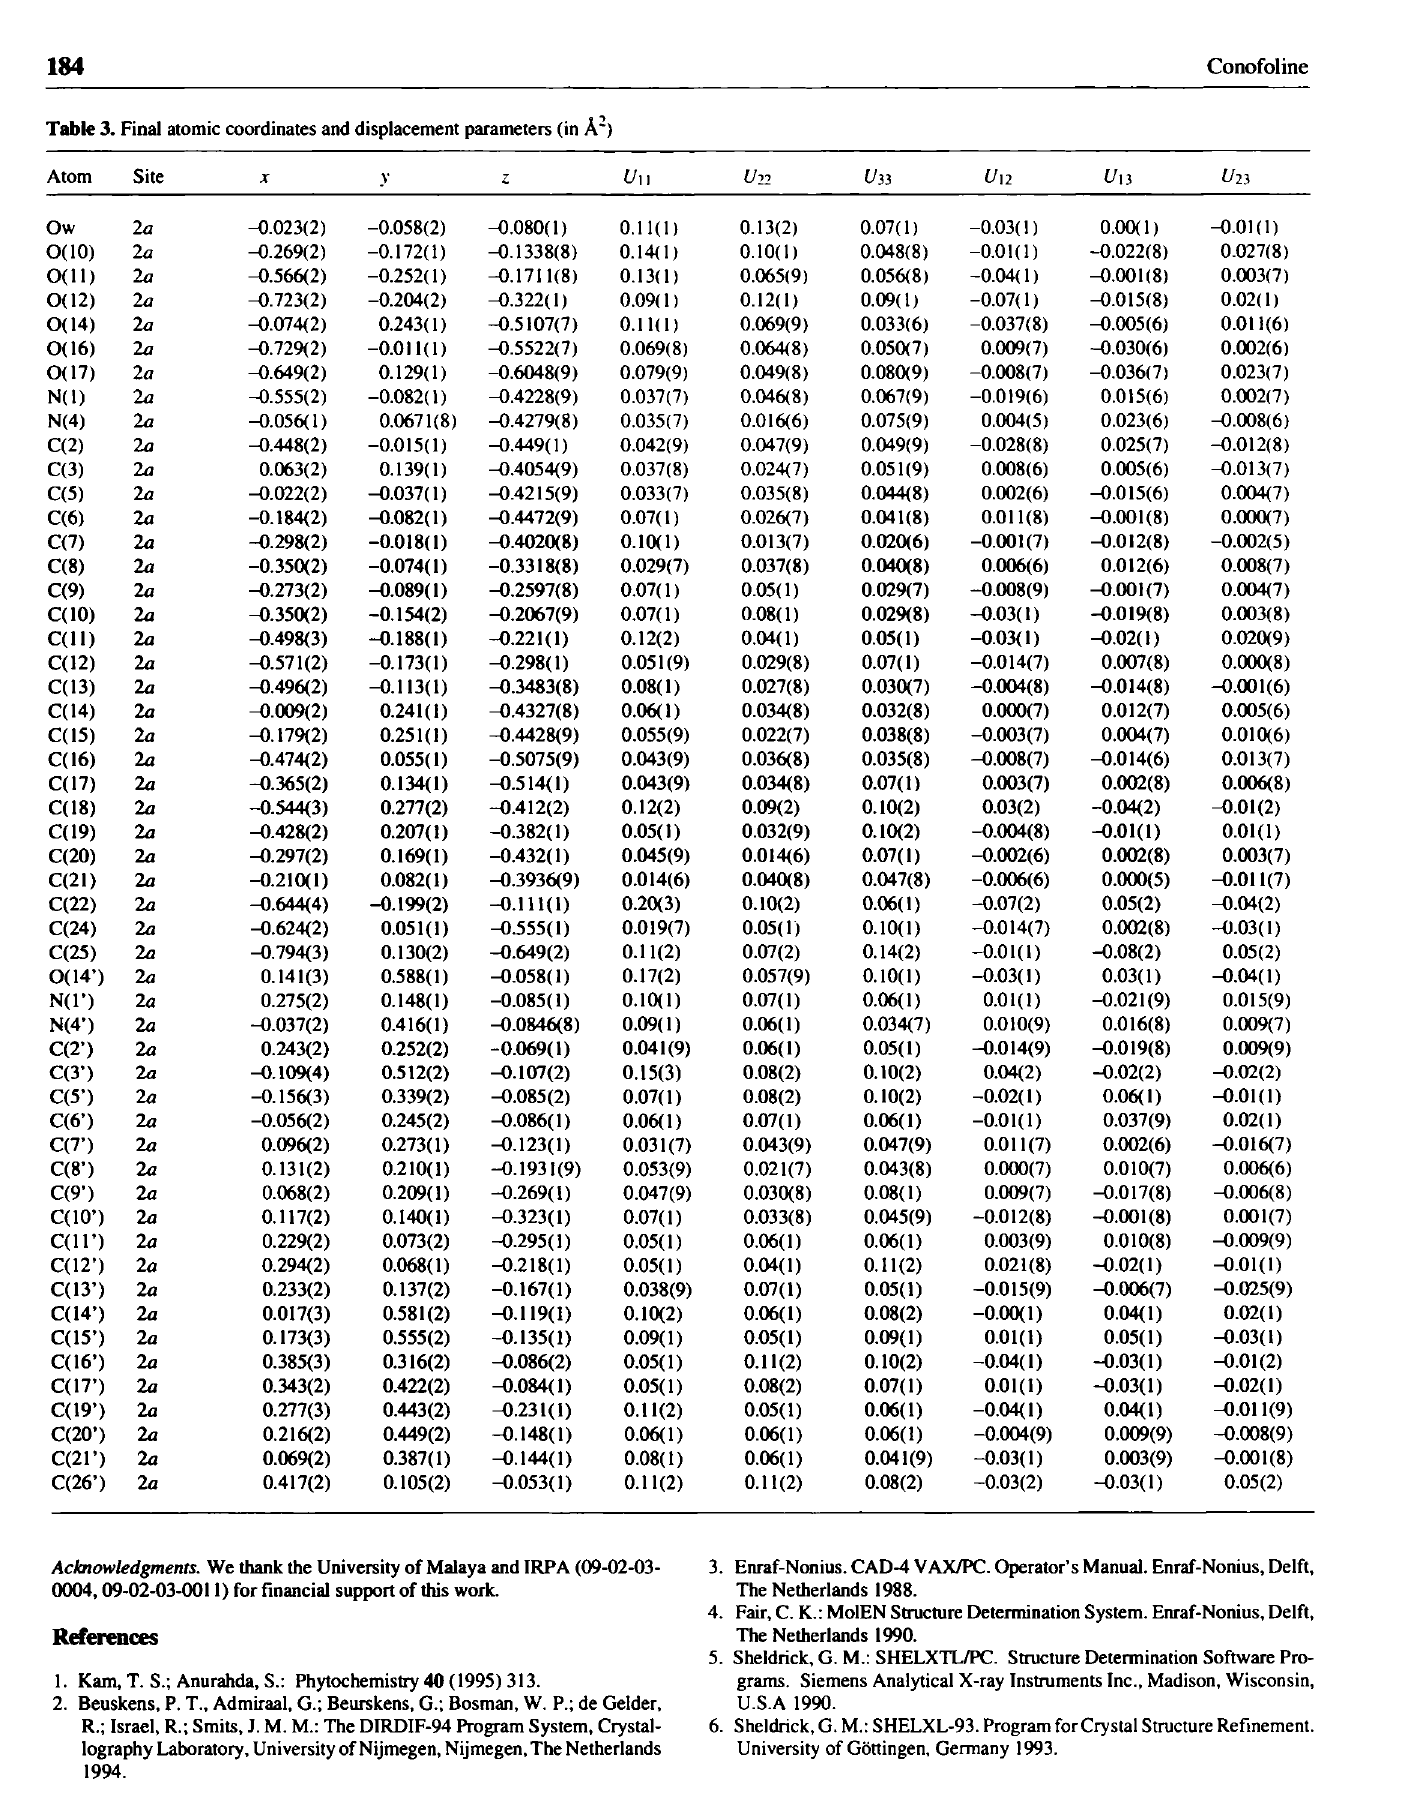
Table 3. Final atomic coordinates and displacement parameters (in